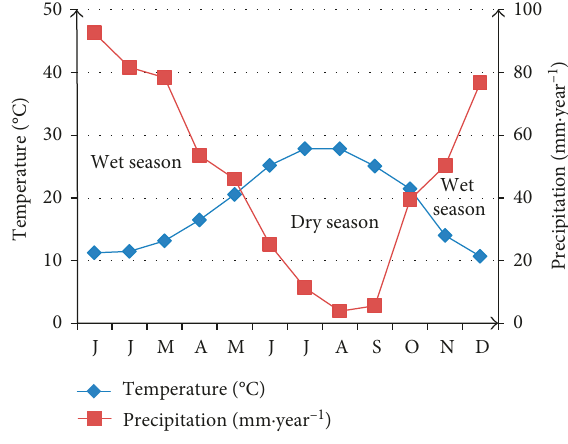
Figure 2: Ombrothermic